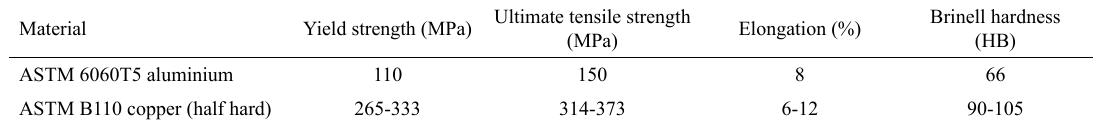
Table 1. Mechanical properties of tested materials